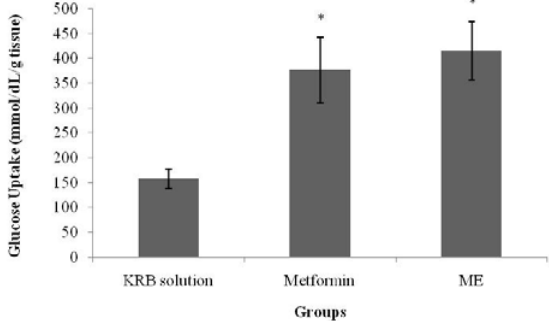
Figure 6. The effect of the methanolic extract (ME) of S. polyanthum and metformin on glucose uptake by isolated rat abdominal muscle in the absence of insulin. Values are expressed as mean ± standard error of the mean (SEM) ( n = 5); * p < 0.05, compared with the control group (KRB solution).